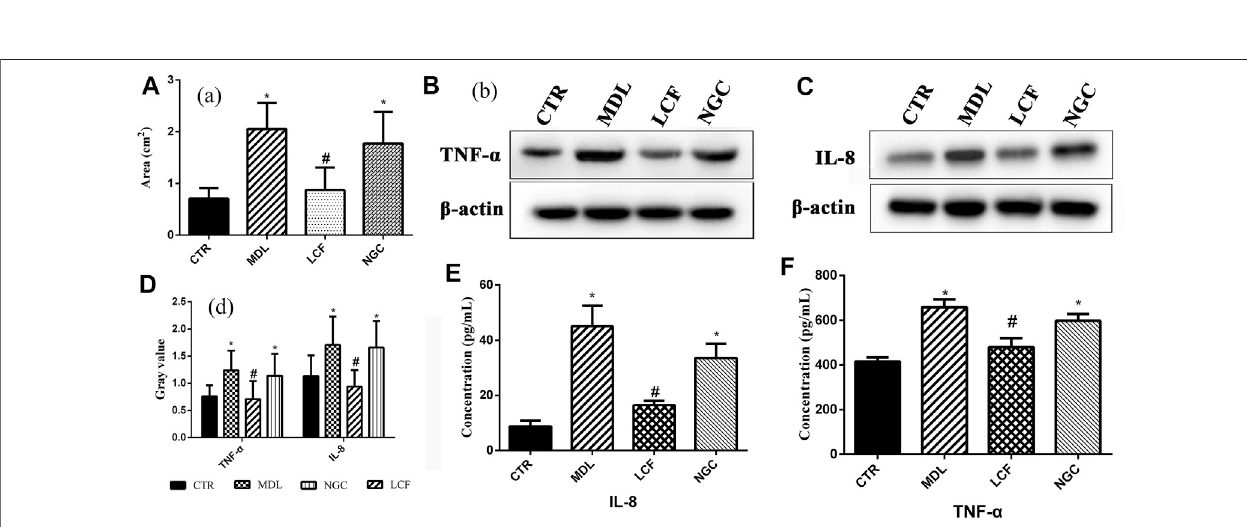
Frontiers in Pharmacology |